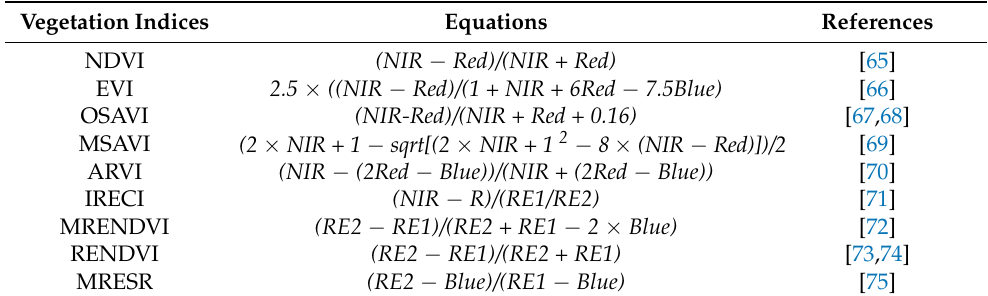
Table 1. Vegetation indices calculated from Sentinel-2 used in the study. Blue, Red, RE1, RE2 and NIR correspond to the Sentinel-2 bands 2,4,5,6 and